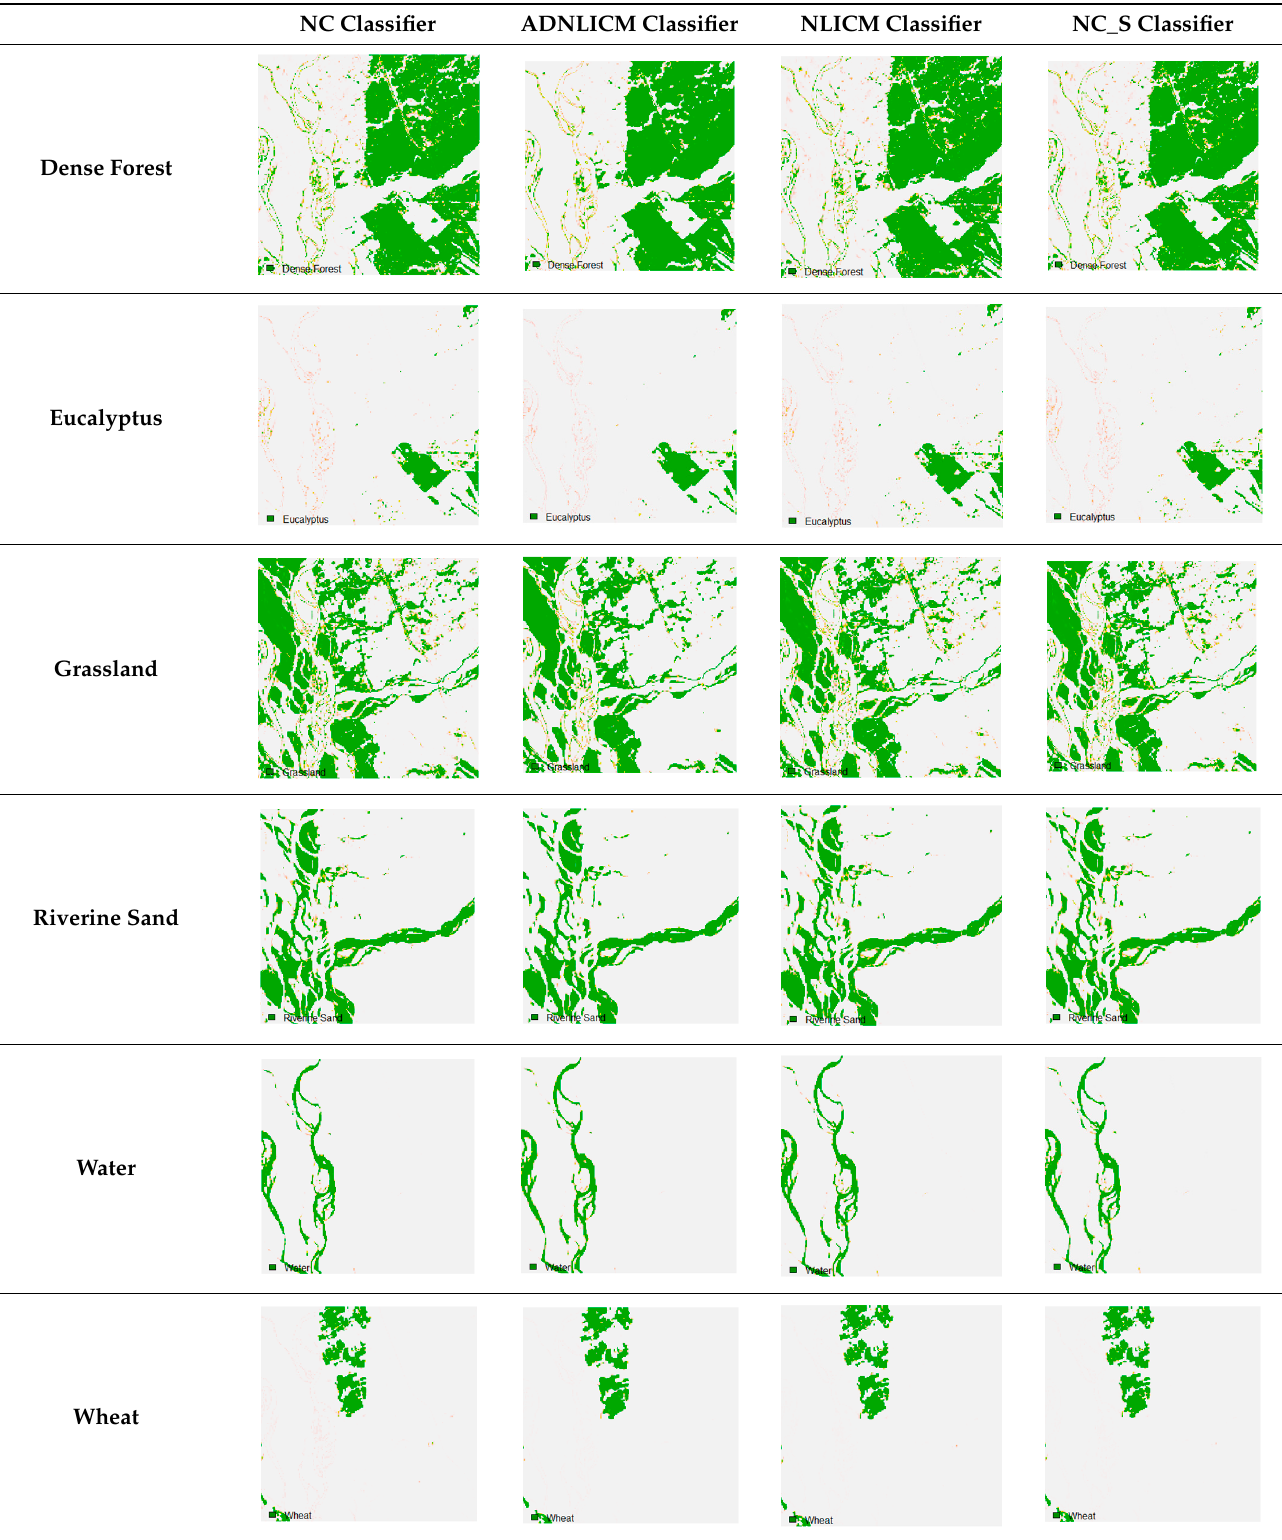
Table 9. Classified classes for each algorithm for site 1 (Haridwar).